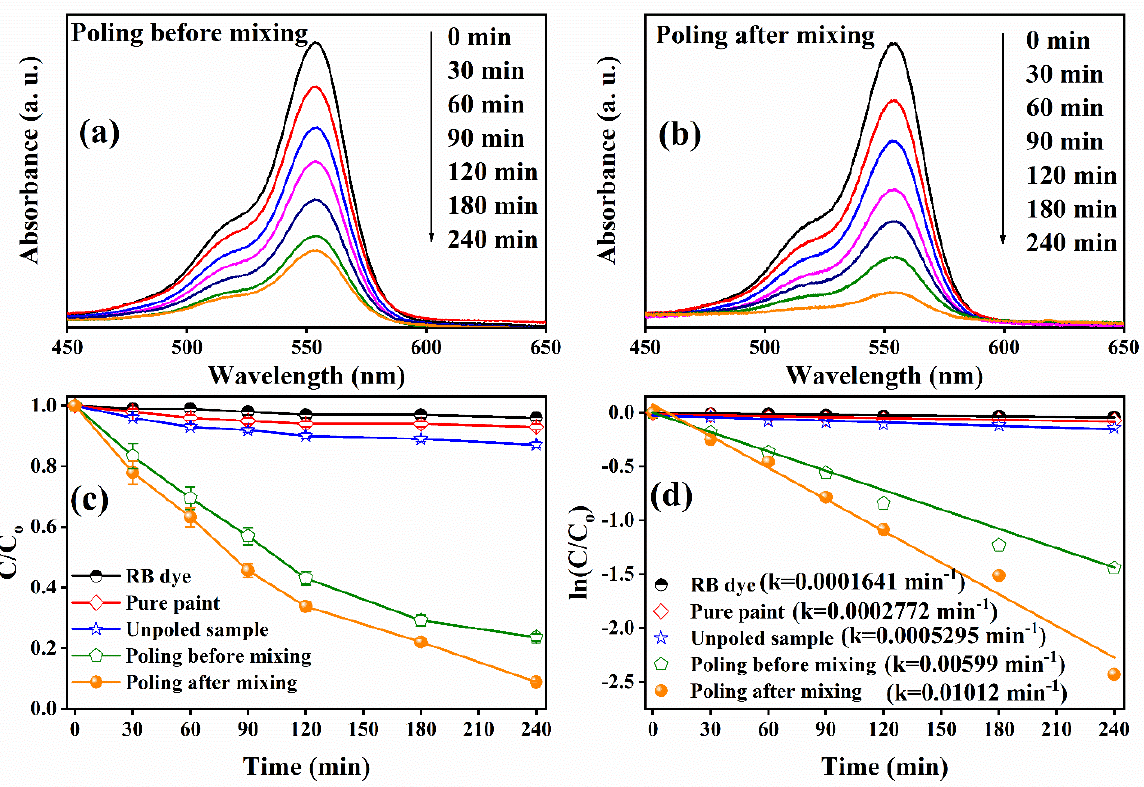
Figure 4. ( a , b ) Absorbance spectra of RB dye during piezocatalytic performance of the BT-polymer composite paint before and after mixing, ( c ) C/C 0 vs. time plots, and ( d ) kinetic rate constant for all the samples.